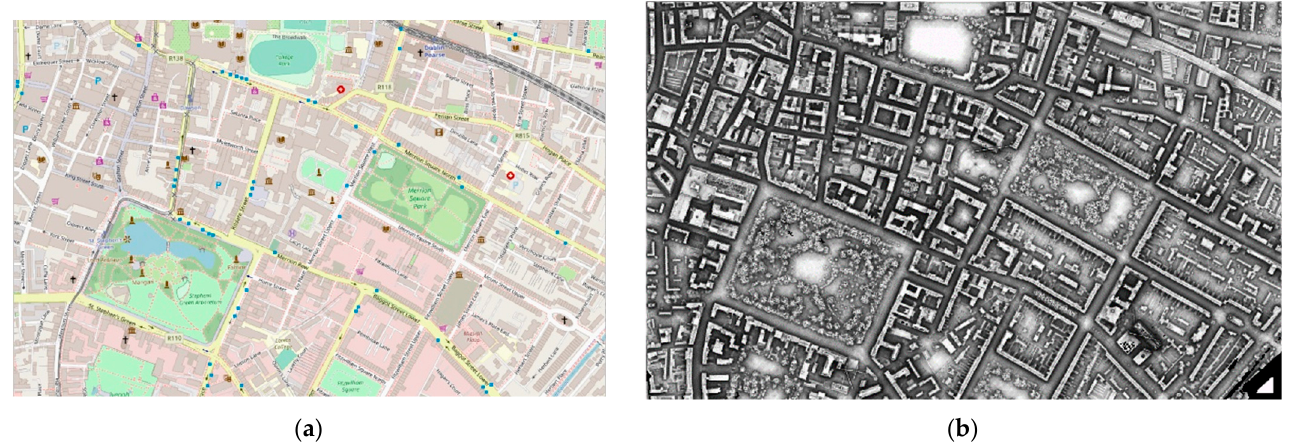
Figure 9. ( a ) The figure shows an OpenStreetMap image of the Dublin test area (© OpenStreetMap contributors) and ( b ) shows the right image shows the sky visibility at each point as modelled by the terrain shading algorithm in terms of no visibility (0 or black) to complete visibility of the upper hemisphere (1 or white). For the area shown here the median value of the upward hemisphere visible is 64%.